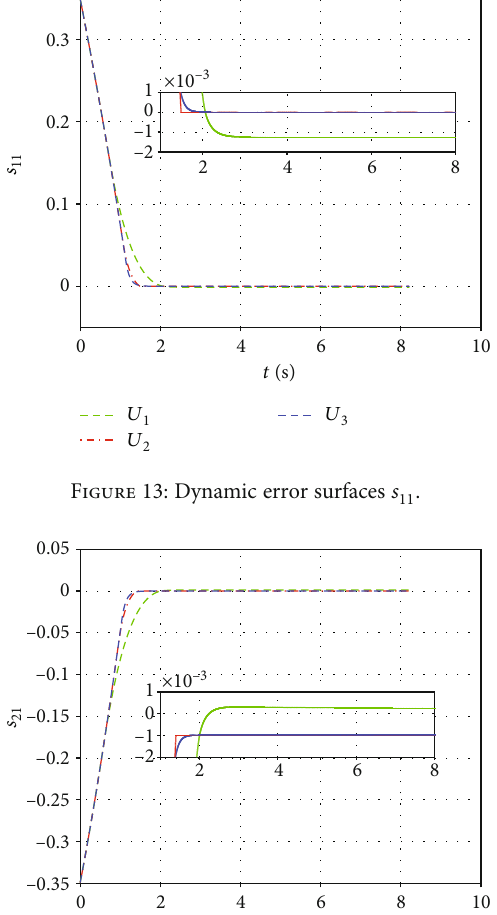
Figure 14: Dynamic error surfaces s